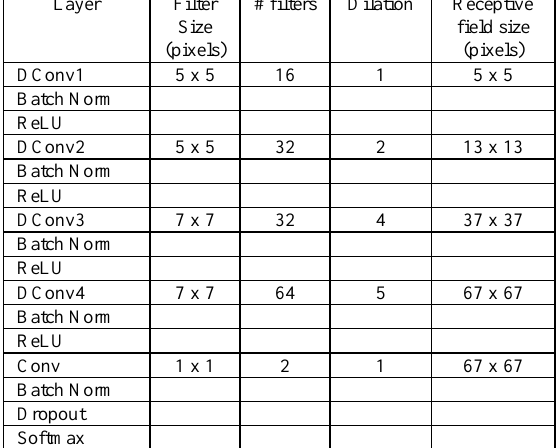
Table 1. Filter number and receptive field